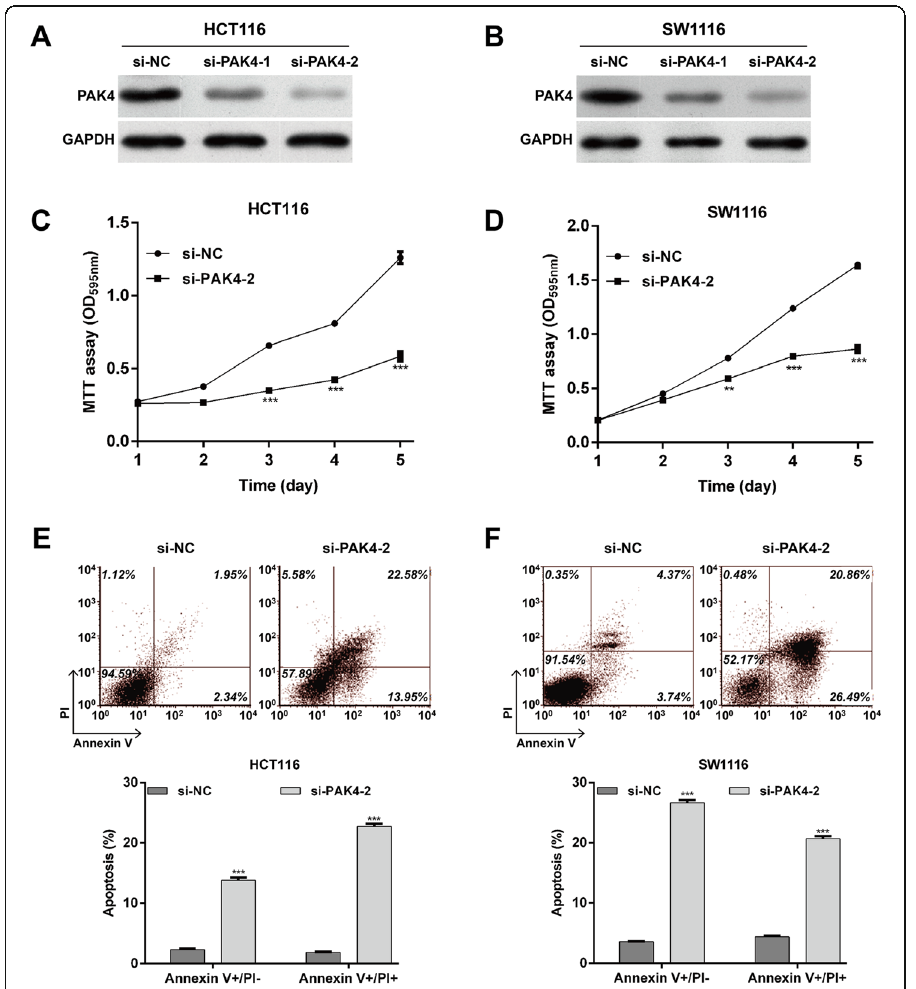
Fig. 2 Effects of PAK4 knockdown on cell proliferation and apoptosis in CRC cells. a and b Western blot analysis was performed to detect PAK4 protein expression in HCT116 and SW1116 cells after transfection with si-NC, si-PAK4 – 1 or si-PAK4 – 2 for 48 h. c and d The MTT assay was used to evaluate cell proliferation ability in HCT116 and SW1116 cells on consecutive 5 days. e and f Flow cytometry was performed to determine cell apoptosis in HCT116 and SW1116 cells. All data are expressed as the means ± SD. ** p < 0.01, *** p < 0.001, compared with the si-NC